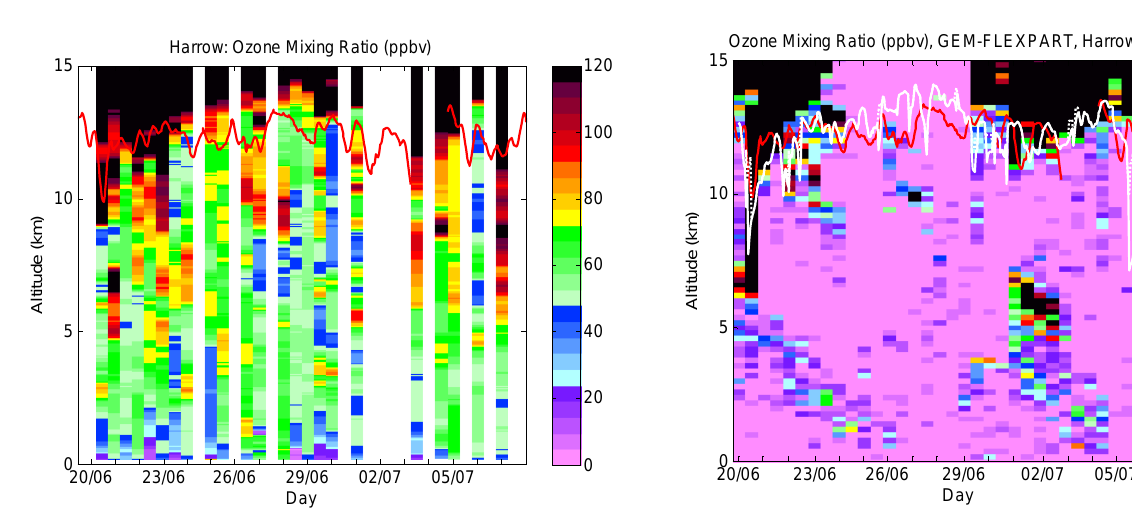
Figure 2: Vertical profiles of ozone mixing ratio (ppbv) for the BAQS-Met campaign at Harrow, Fig. 2. Vertical profiles of ozone mixing ratio (ppbv) for the BAQS- Ontario, in the summer of 2007. The red solid line shows the tropopause height derived from the Met campaign at Harrow, Ontario, in the summer of 2007. The red radar data. Date and time are UTC. solid line shows the tropopause height derived from the radar data. Date and time are UTC.